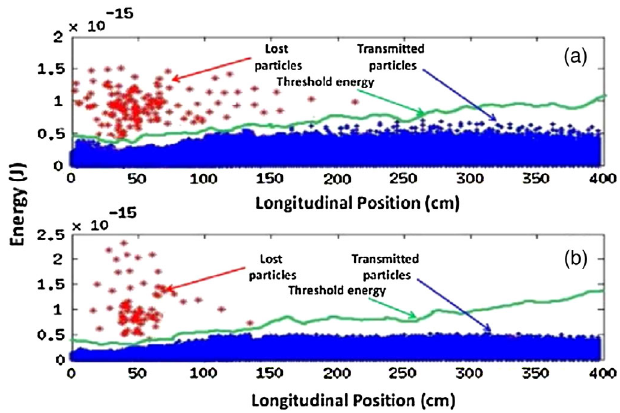
FIG. 16. Transverse threshold energy plot as a function of longitudinal position overlapped with particles transverse energy: (a) for the Gaussian beam and (b) for the